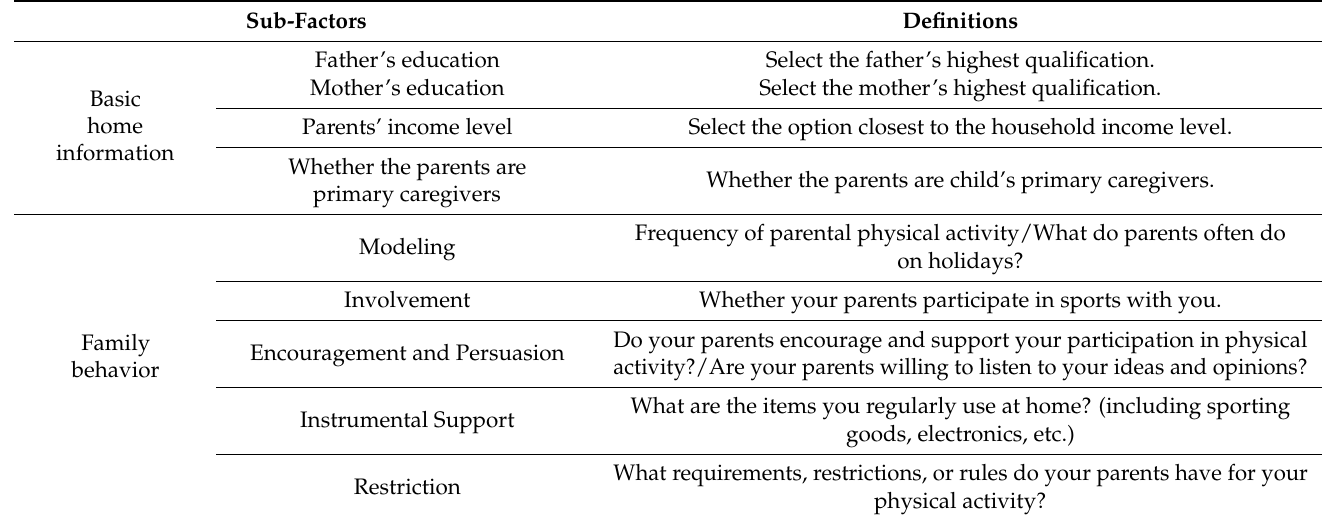
Table 4. Sub-factors of influence of family environment and